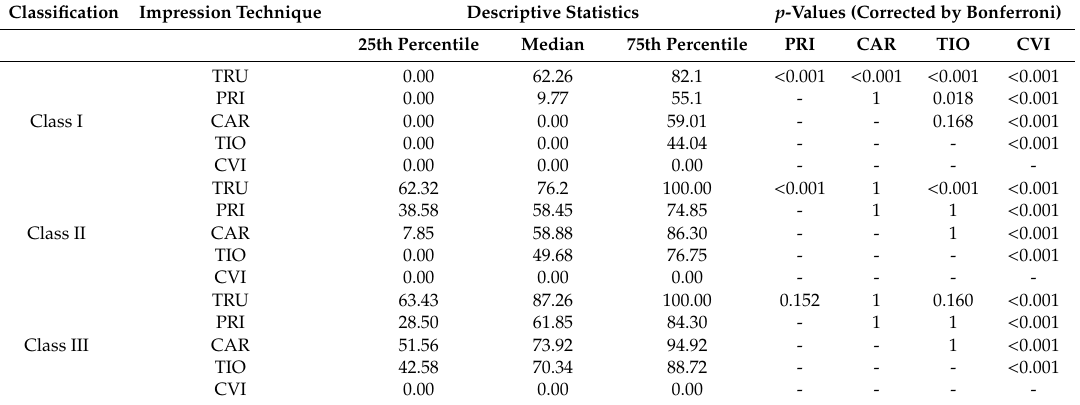
Table 3. Descriptive statistics and results of the Median test corrected by the Bonferroni method for anterior teeth.